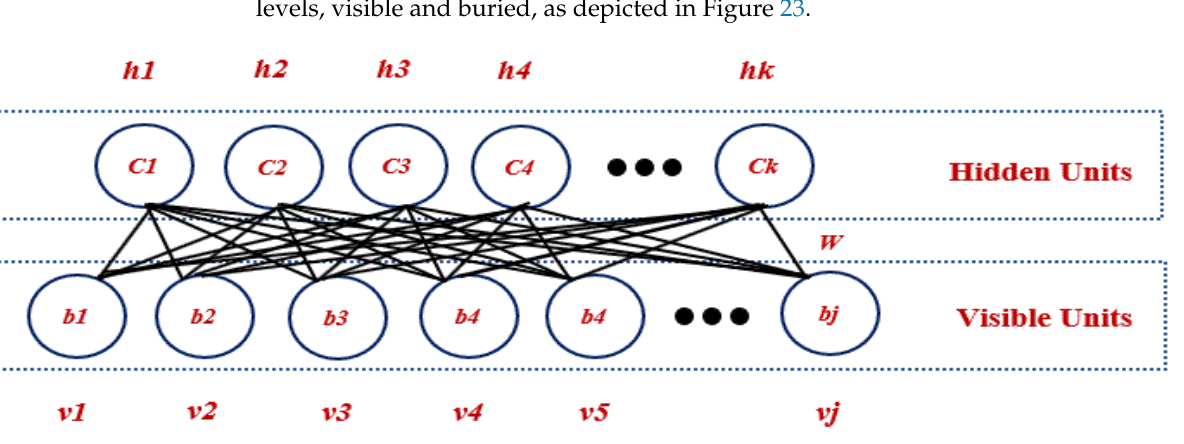
Figure 23. Structure of a restricted Boltzmann machine.